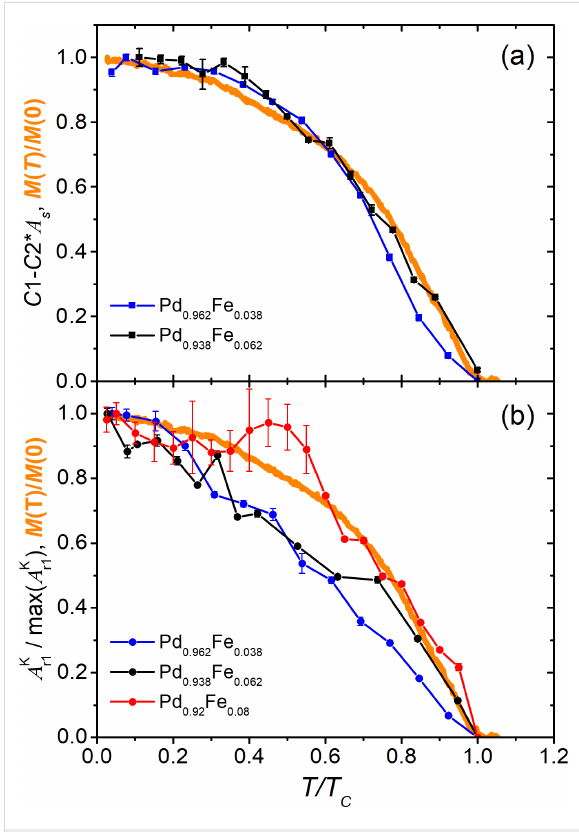
Figure 5: Temperature dependences of the reflectivity slow relaxation amplitudes of the Pd 0.962 Fe 0.038 (blue) and Pd 0.938 Fe 0.062 (black) samples, transformed and normalized in magnitude for their compari- son with the dependence of the saturation magnetization (thick orange line) (a); the same for the Kerr rotation angle dependences